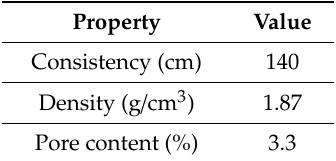
Table 1. Properties of mortar in its fresh